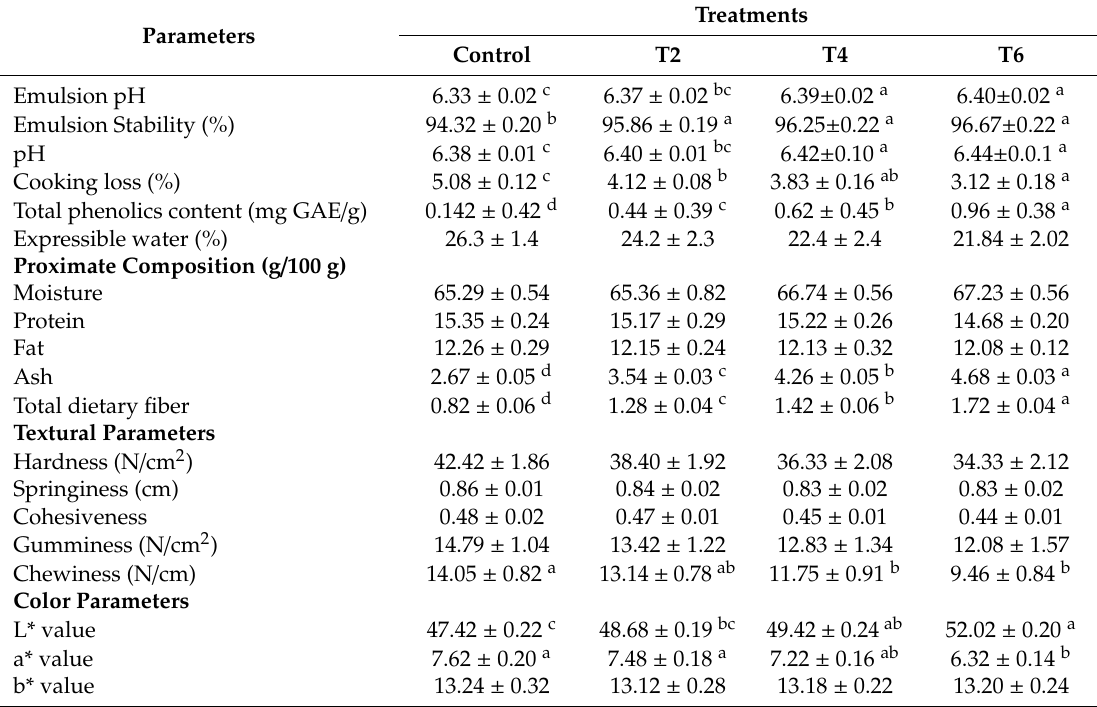
Table 3. E ff ect of enoki mushroom stem waste (MSW) on the physicochemical, textural and color attributes of goat meat nuggets ( n =